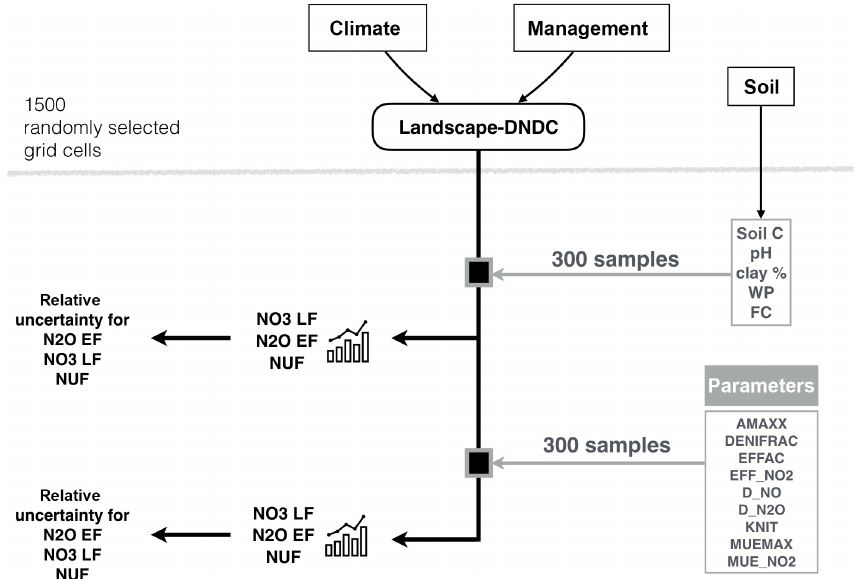
Table 2. Regional-scale input data sources Type Source Variables Temporal Spatial res- resolution olution Soil Scottish Soil Database soil depth, pH, C, bulk density, clay con- N/A 1km 2 tent, wilting point and field capacity Crop EDINA AgCensus harvested area per crop type 2011–2013 4km 2 Climate CHESS precipitation, max/min T 2011–2013 1km 2 Management HGCA crop growth guides planting/harvest dates, recommended fer- N/A fertiliser manual (RB209) tiliser rates, fertiliser application dates